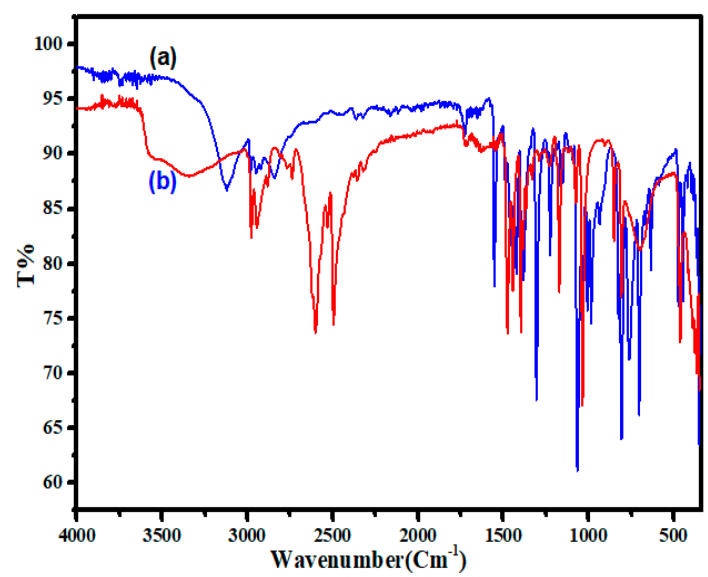
Figure 5. FT-IR of (a) 3,5-dimethylpyrazole (NNH) ligand and (b) the desired cluster.